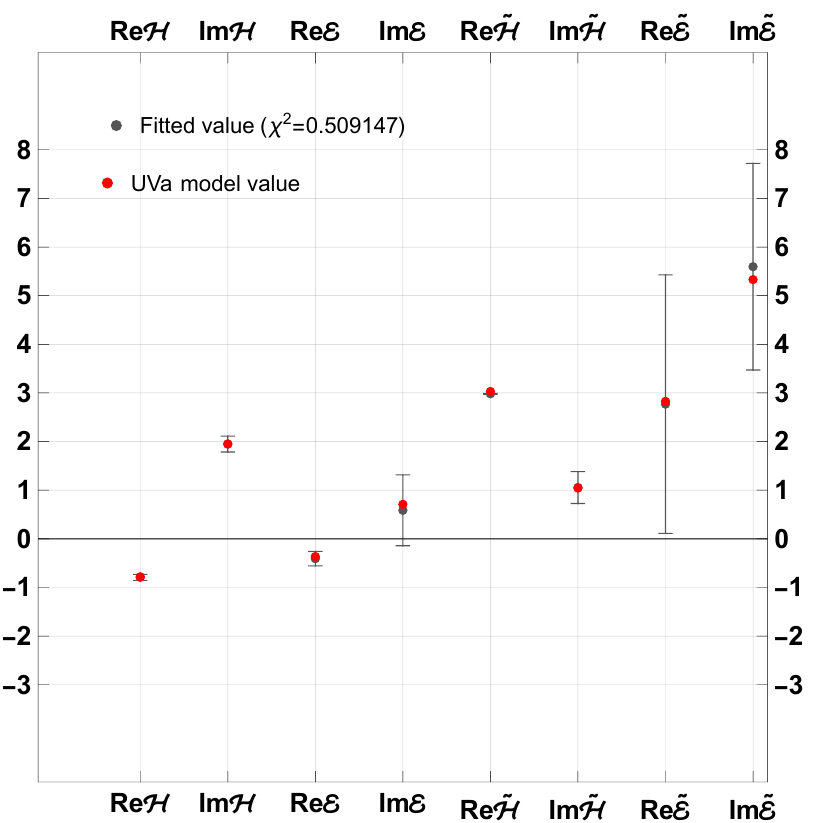
Figure 8. Comparison of the 8 twist-2 CFFs extracted from all possible polarization cross sections and their UVa model value used to generate the